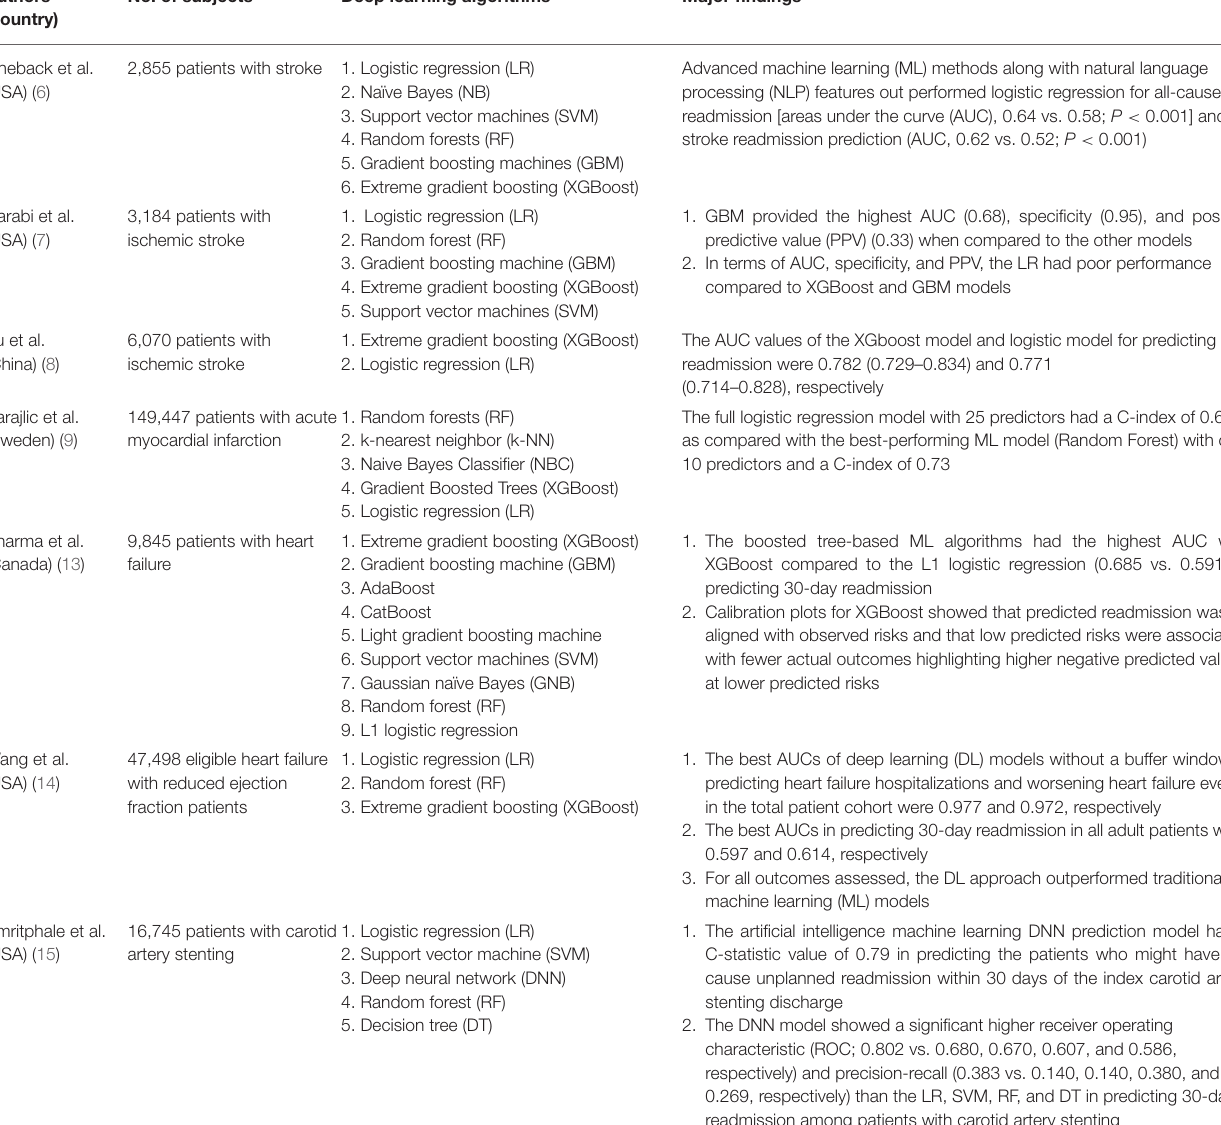
TABLE 1 | The studies in predicting 30-day readmission for patients by using machine learning. Authors